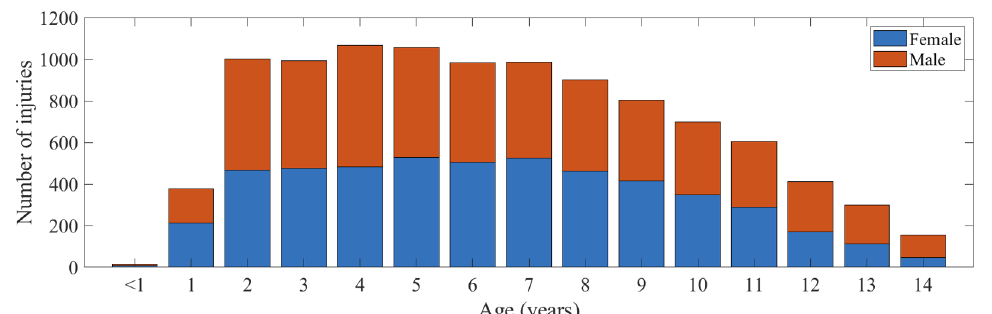
Figure 2. Number of injuries by age.